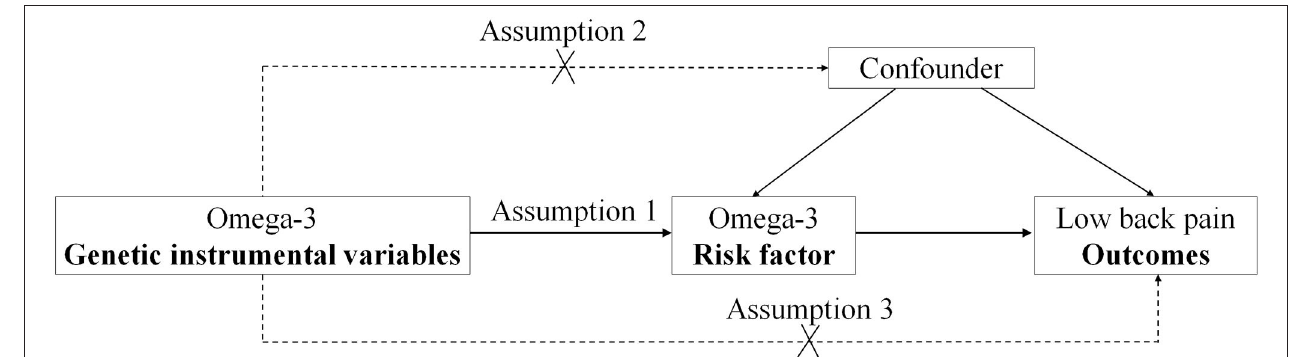
FIGURE 1 | The design flow chart for the Mendelian randomization (MR) study. MR assumptions: assumption 1, 2, and 3. The solid line represents direct putative causal effects that plasma omega-3 genetic instrumental variants are reliably associated with I plasma omega-3 levels and influence the risk of low back pain through the plasma omega-3 in assumption 1. The dotted line represents that plasma omega-3 genetic instrumental variants are not associated with any measured and unmeasured confounders and do not influence the risk of low back pain through other pathways in assumptions 2 and 3, respectively.